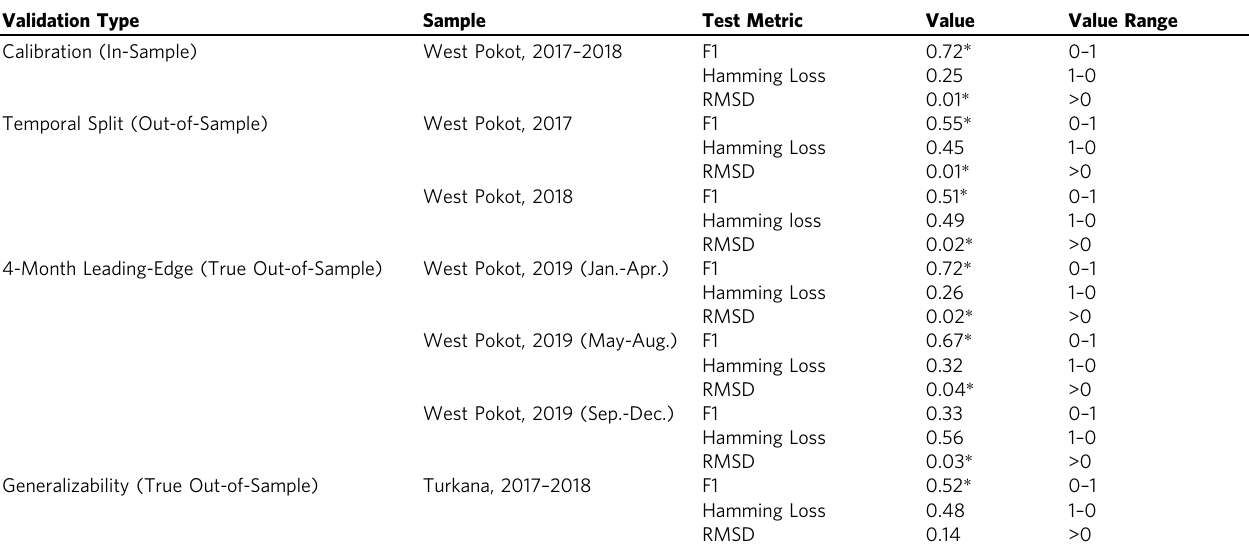
Table 1 Summary of validation exercises and quantitative model performance statistics.